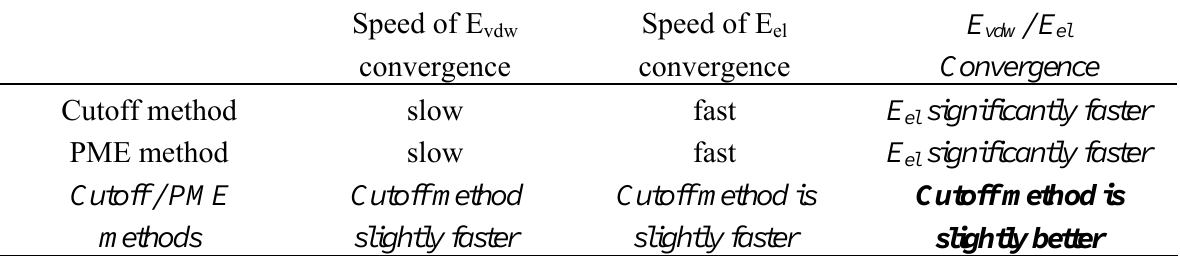
Table 5. Summary of results for peptides and proteins.